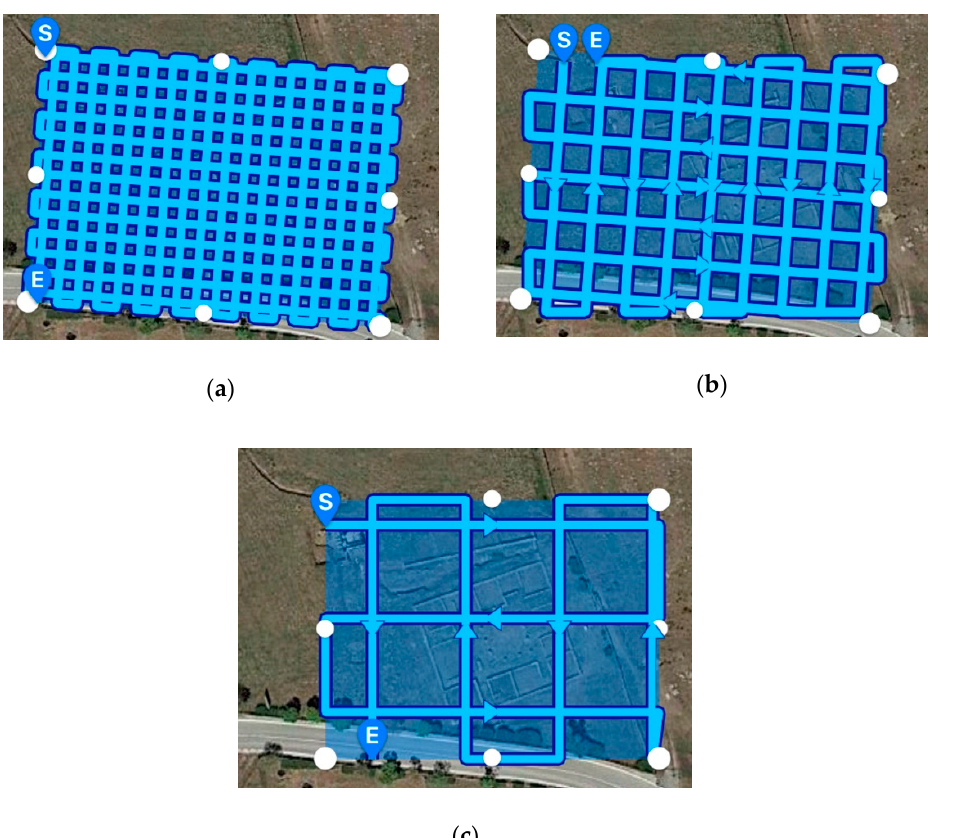
Figure 4. Itineraries of different flights. ( a ) Flight number 3 (height of flight: 15 m; forward overlap: 80%; lateral overlap: 80%). ( b ) Flight number 1 (height of flight: 15 m; forward overlap: 60%; lateral overlap: 60%). ( c ) Flight number 4 (height of flight: 45 m; forward overlap: 60%; lateral overlap: 70%).